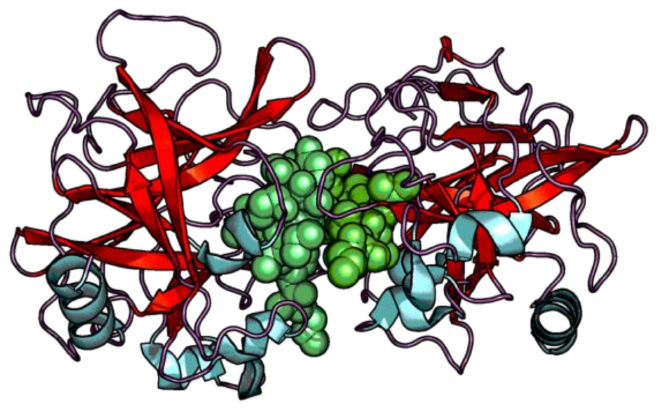
Figure 10. Binding structure of elastase inhibitor Scyptolin A (PDB code: 1OKX) [107]. The inhibitor molecules are presented as